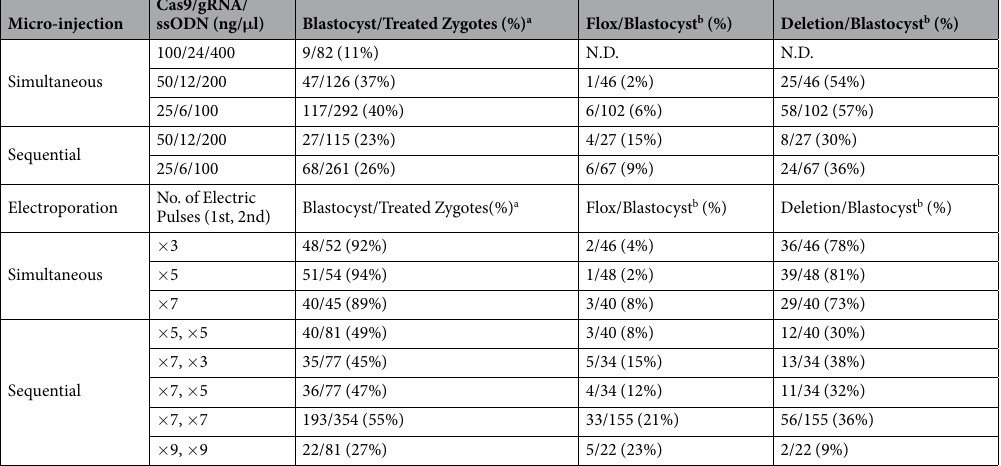
Table 1. Generation of Mecp2 Flox Blastocyst Embryos. Samples were analyzed at the blastocyst stage. N.D., not determined because of poor in vitro development. a Embryo survival rates (blastocyst/treated zygote). b Samples that were not amplified by PCR were excluded because they could have contained chromosomal deletions. Detailed data are shown in Table S1.